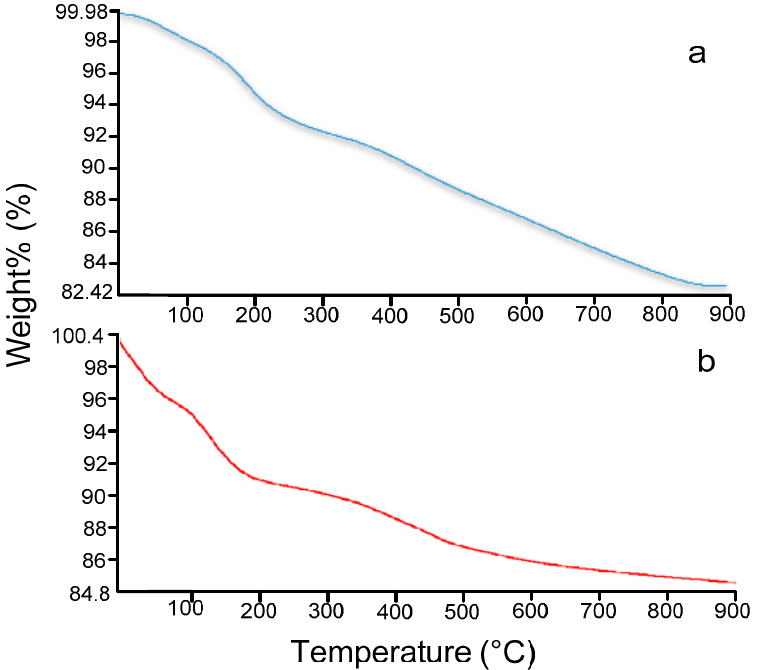
Figure 2. Thermogravimetric analysis of the silica-bound C -butylpyrogallol[4]arene stationary phases: ( a ) HPLC grade 3a and ( b ) flash column chromatography grade 3b . ( a ) HPLC grade 3a and ( b ) flash column chromatography grade 3b